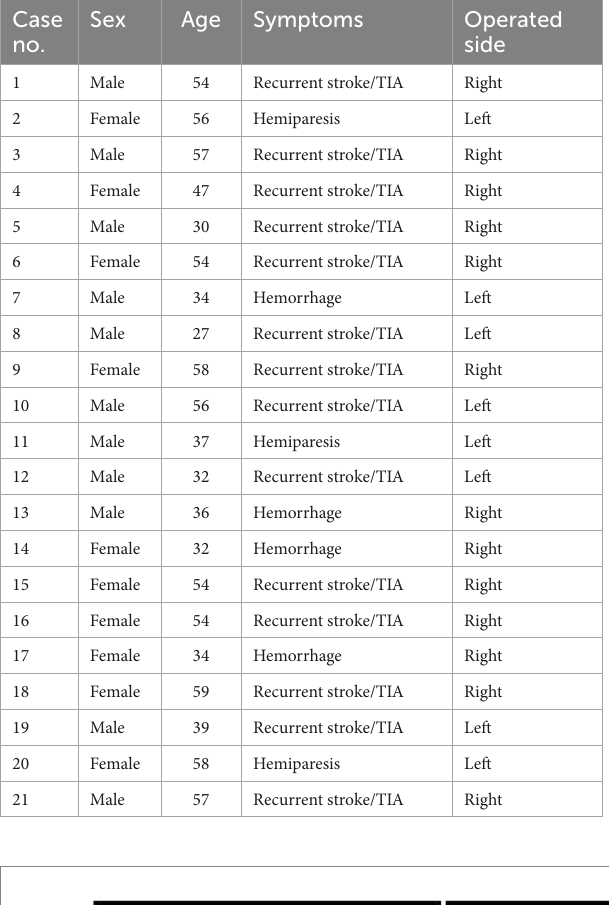
TABLE 1 Clinical characteristics of the study